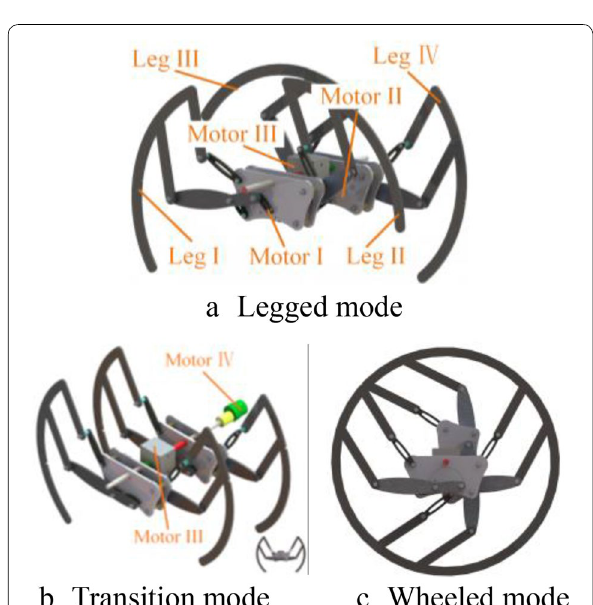
Figure 6 Walking